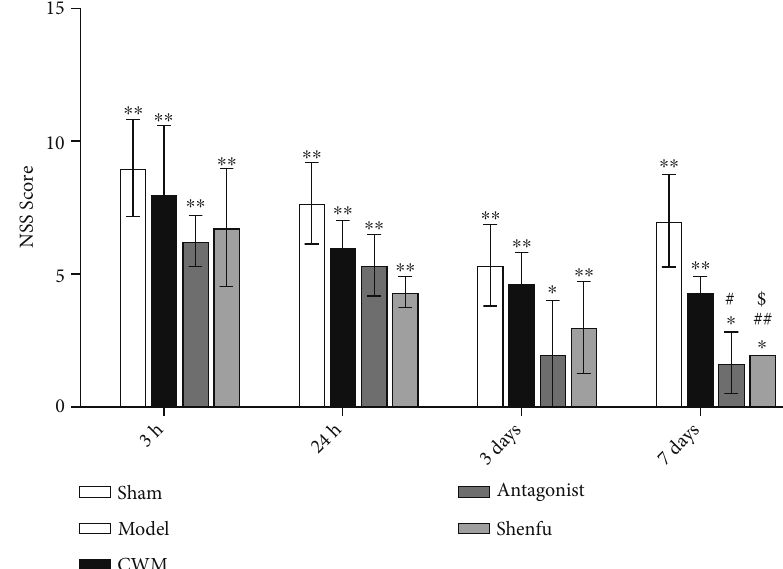
Figure 1: The neurological function scores (mNSS) in each group at 3 hours, 24 hours, 3 days, and 7 days. n = 8 in each subgroup at di ff erent time. Compared with the Sham group, * P < 0 : 05 and ** P < 0 : 01 ; compared with the model, # P < 0 : 05 and ## P < 0 : 001 ; compared with the conventional western medicine, $ P < 0 : 05